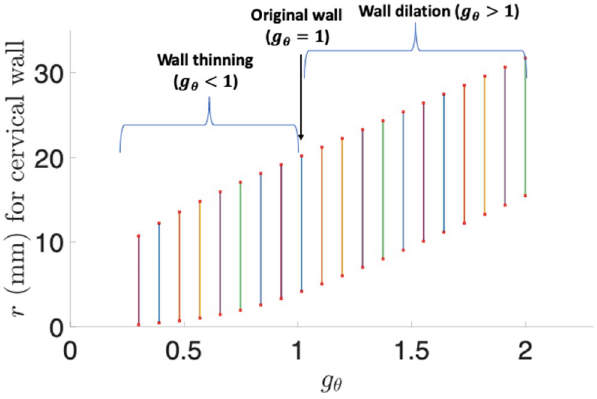
Fig 5. The cervical wall radius and thickness for the circumferential growth parameter g θ over a continuous interval (0.3, 2). The top points of the vertical lines represent r 4 , the bottom points represent r 1 , and the length of each vertical line represents the wall thickness.